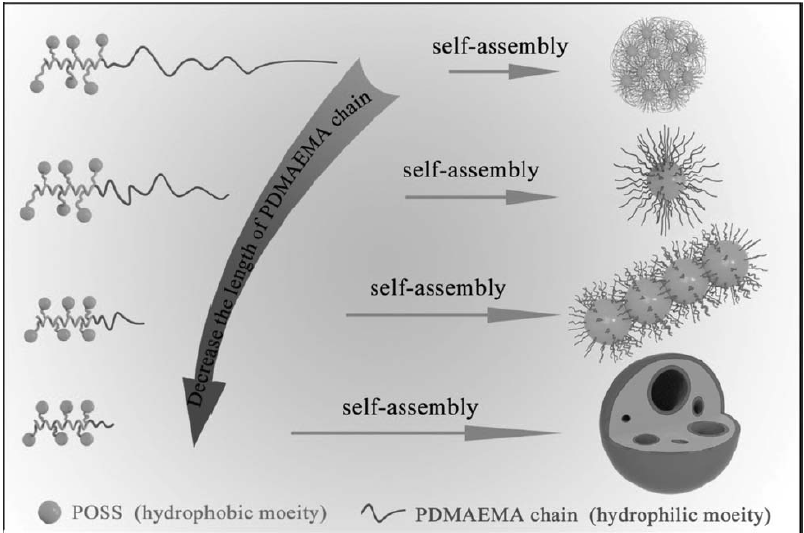
Figure 9. Self-assembly of poly(2-hydroxyethyl methacrylate-POSS)- b -(poly(methyl methacrylate)) (PHEMAPOSS- b -PDMAEMA) in water with the decreasing length of the hydrophilic PDMAEMA chain. Reprinted with permission from [114]. Copyright (2014) John Wiley and Sons.